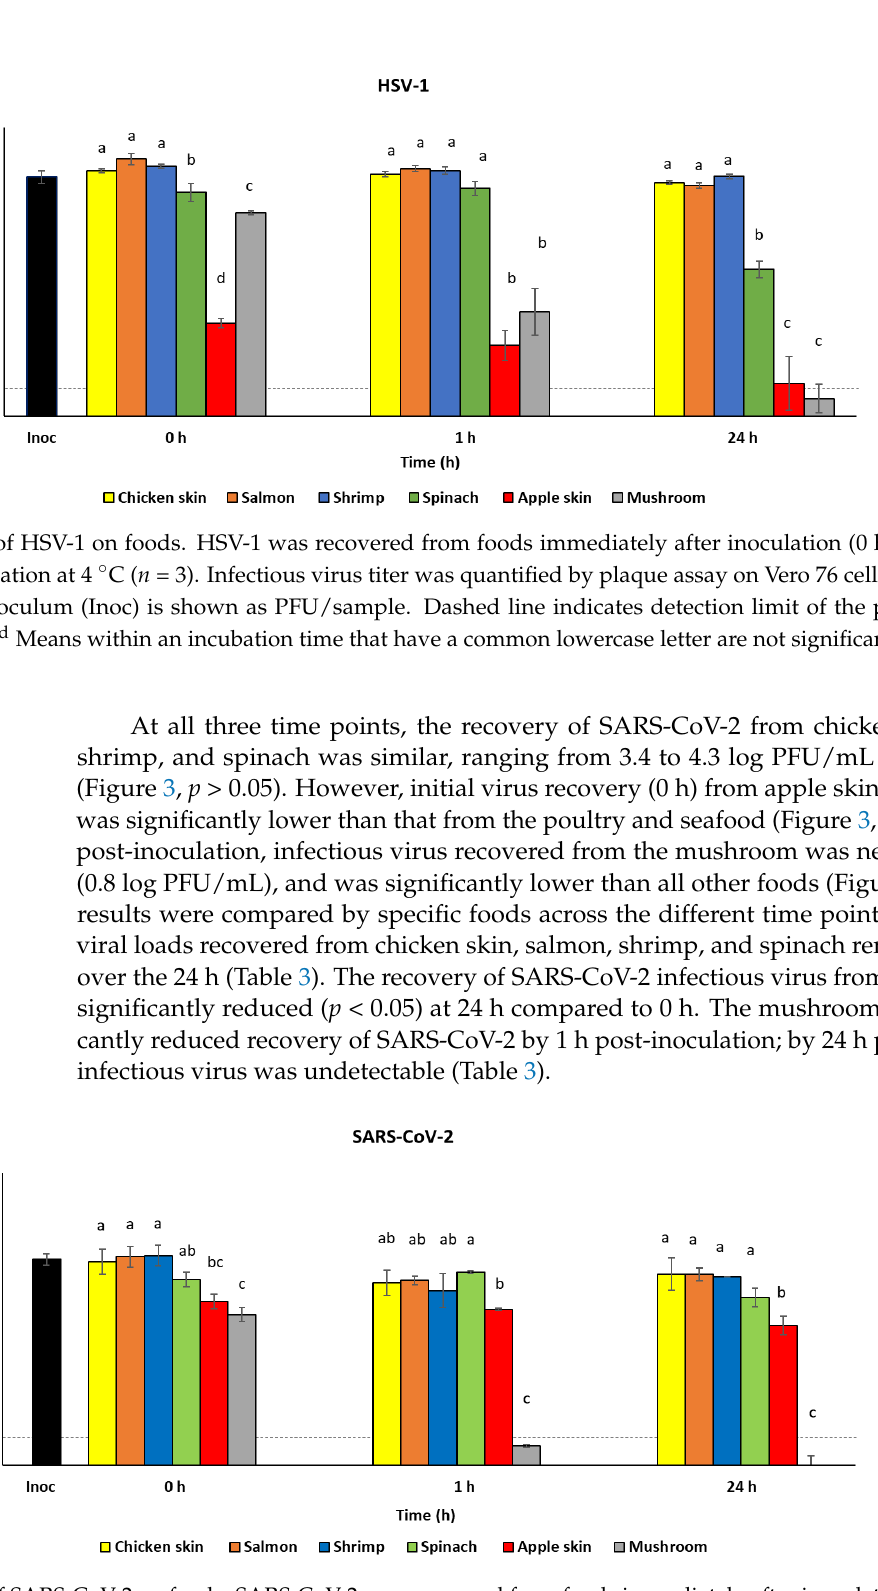
Figure 3. Survival of SARS-CoV-2 on foods. SARS-CoV-2 was recovered from foods immediately after inoculation (0 h) and at 1 h and 24 h after incubation at 4 °C ( n = 3). Infectious virus titer was quantified by plaque assay on Vero E6 cells and shown as log PFU/mL. Inoculum (Inoc) is shown as PFU/sample. Dashed line indicates detection limit of the plaque assay (0.7 log PFU/mL). a–d Means within an incubation time that have a common lowercase letter are not significantly different ( p < 0.05).